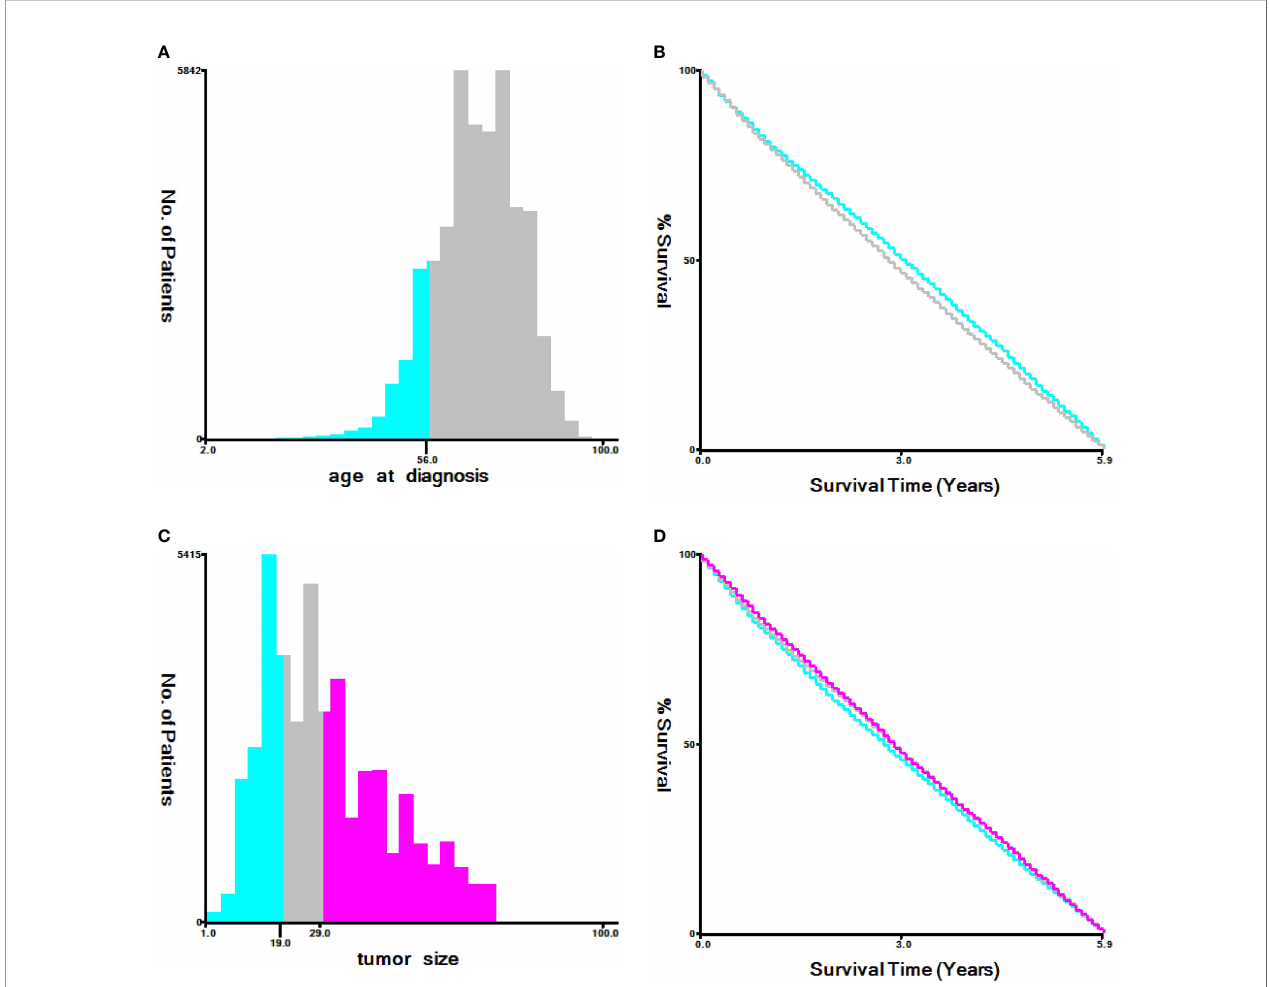
FIGURE 2 | Identi fi cation of optimal cut-off values of age (A, B) and tumor size (C, D) via X-tile software analysis. Optimal cut-off values of age were identi fi ed as 56 based on NCSD. Optimal cut-off values of tumor size were determined as 19 mm and 29 mm based on